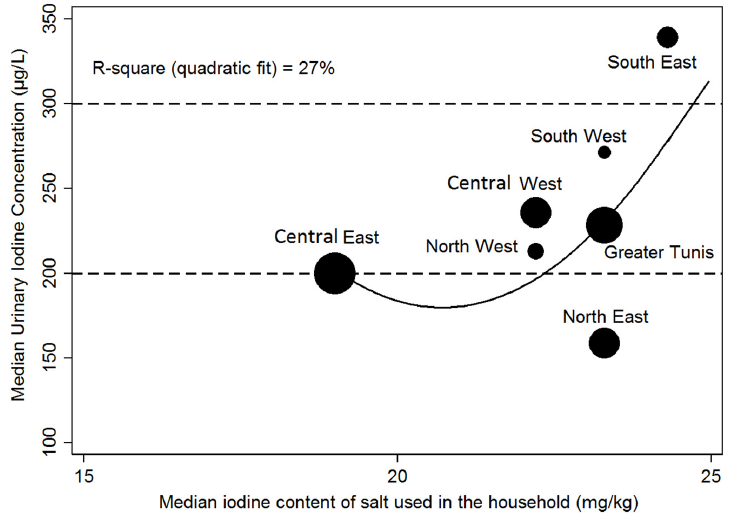
Figure 2. Relationship at the regional level between median salt iodine content and median urinary iodine concentration.